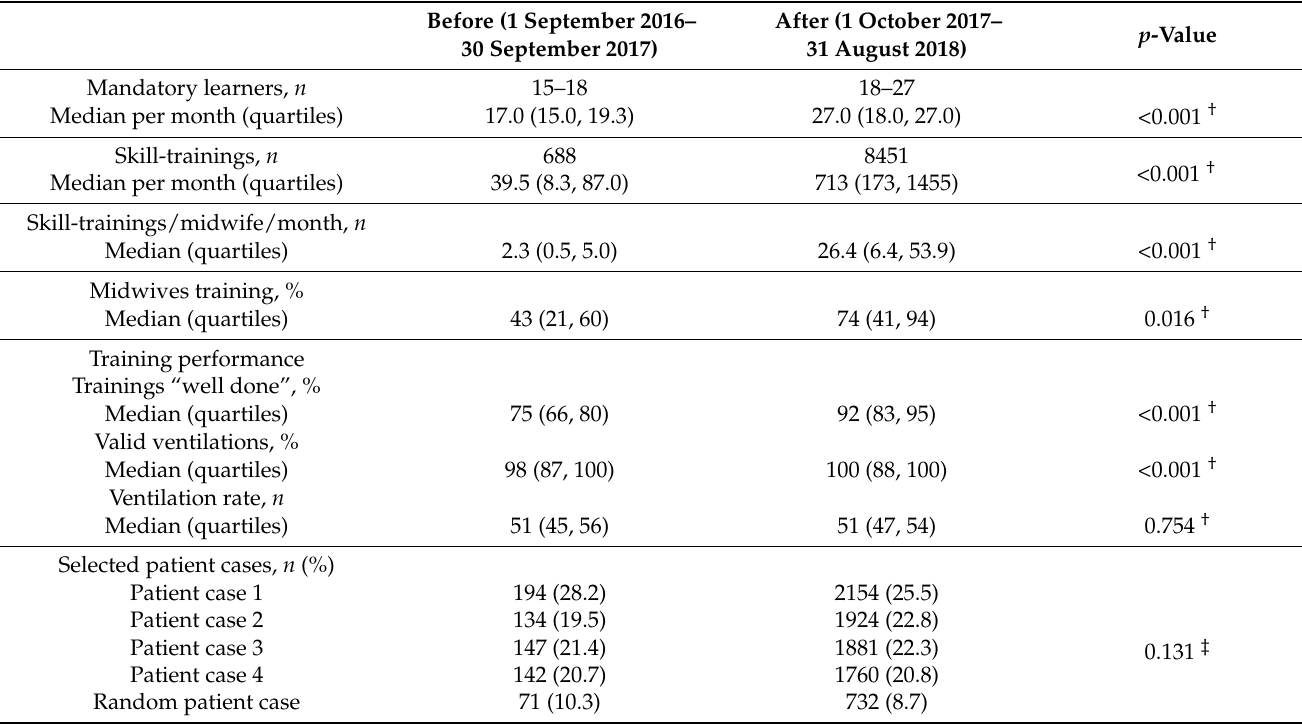
Table 1. Changes in mandatory learners, training frequency, participation, training performance and selection of patient cases for simulation-based skill-training using NeoNatalie Live, comparing the period before and after appointment of local